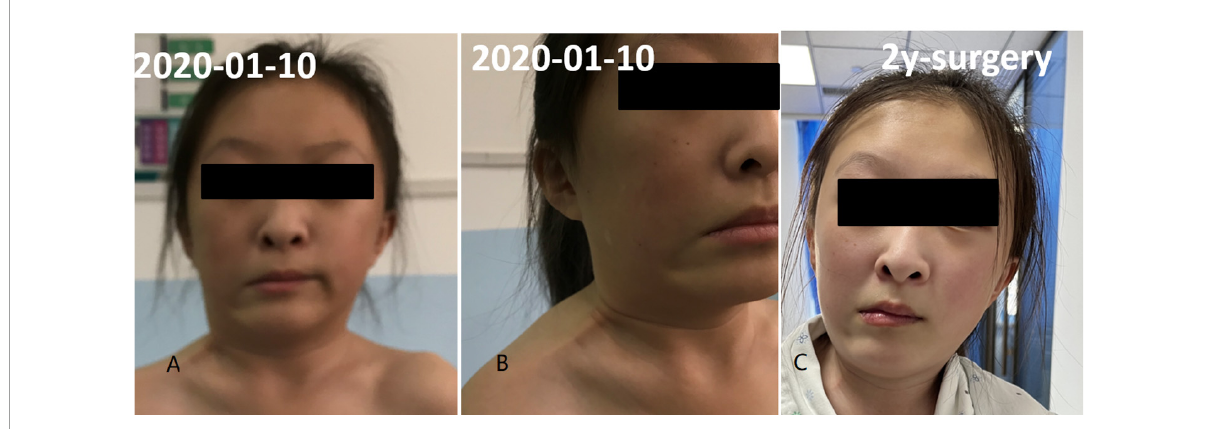
FIGURE1 Fascial contracture of right neck and mandibular angle. Panels (A,B) was preoperative condition and panel (C) was 2 years after